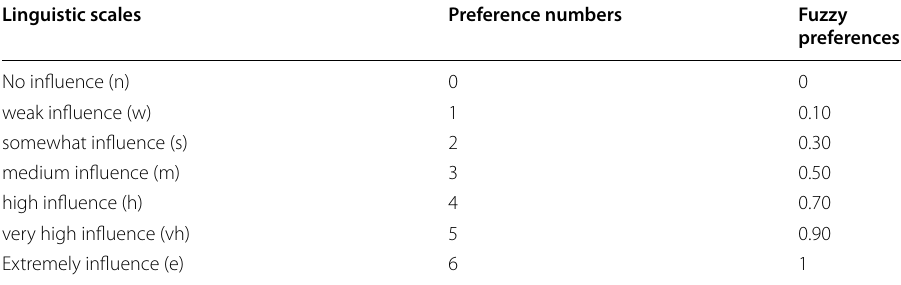
Table 2 Linguistic scales and fuzzy preference numbers Linguistic